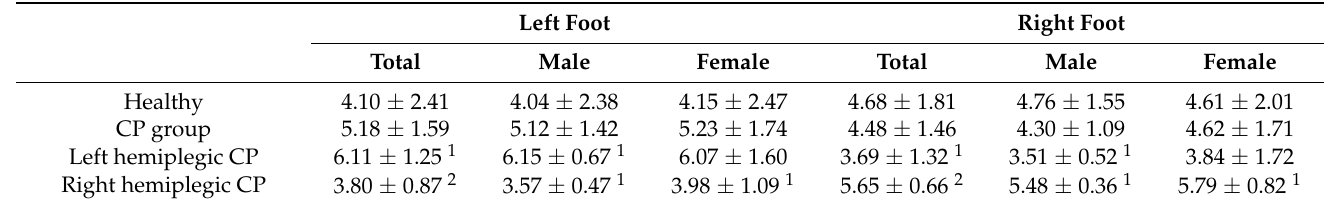
Table 5. Static rearfoot postural alignment for students diagnosed with hemiplegic cerebral palsy and healthy college students.